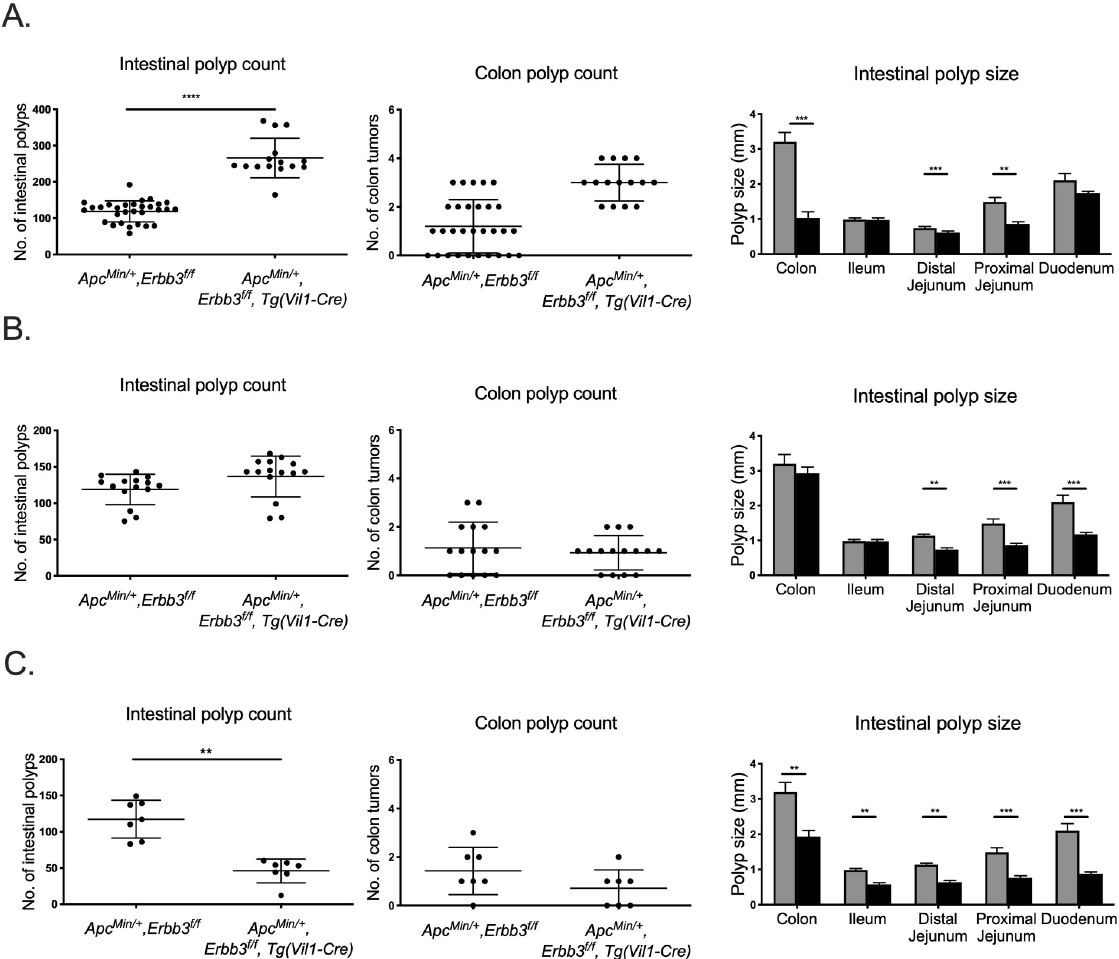
Fig 1. Genetic background alters effect of ERBB3 deficiency on intestinal polyp development. Polyp number and sizes in mice lacking ERBB3 in intestinal epithelium and from Apc Min /+ mice on (A) C57BL/6J; (B) B6129 hybrid background; and (C) B6;129 mixed backgrounds. Each dot represents polyp number in each three-month-old mouse. Grey bars represent mean polyp size in Erbb3 wildtype mice and black bars represent mean polyp size of Erbb3 intestinal epithelia-specific knockout mice. � p-value < 0.05, �� p-value < 0.01, ��� p- value < 0.001, ���� p-value <